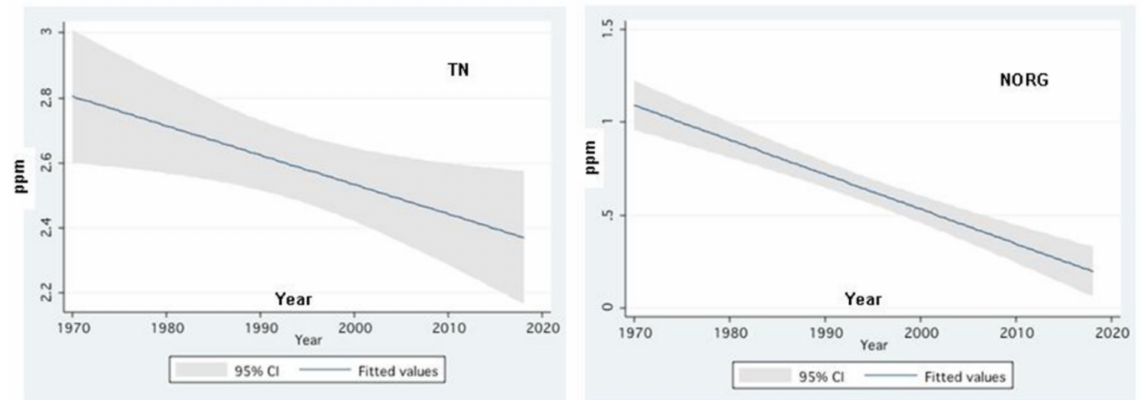
Figure 5. Temporal (1970–2018) changes in annual concentrations (ppm) of total nitrogen ( left ) and organic nitrogen ( right ) in Jordan waters, presented as linear regression (95% CI) between the concentrations and years.